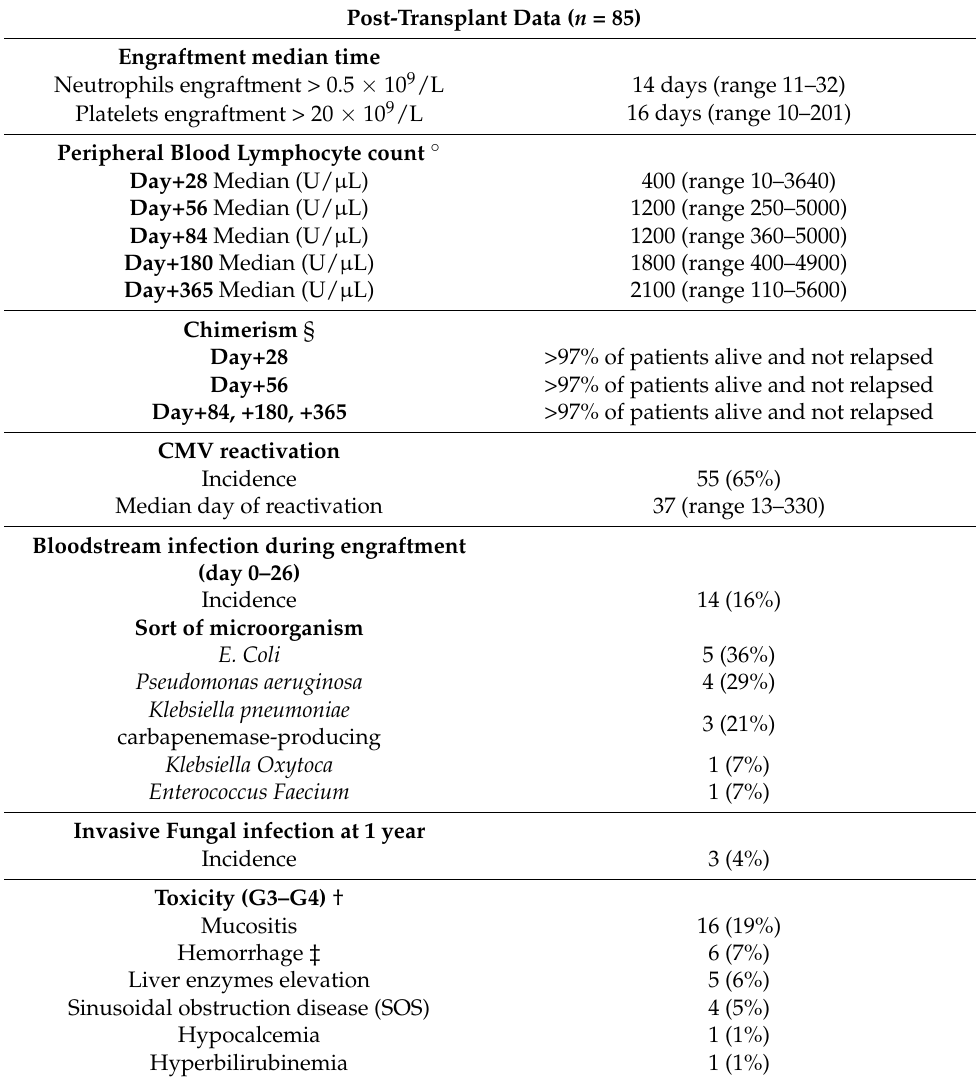
Table 2. Post-transplant data. ◦ Peripheral blood lymphocyte count was available on day 28, 56, +84, +180, and +365 for all survivor patients. § Chimerism on peripheral blood was available for all patients alive without disease relapse. † Toxicities were graded according to standard National Cancer Institute Common Terminology Criteria for Adverse Events version 4.0. ‡ Hemorrhagic cystitis and cerebral